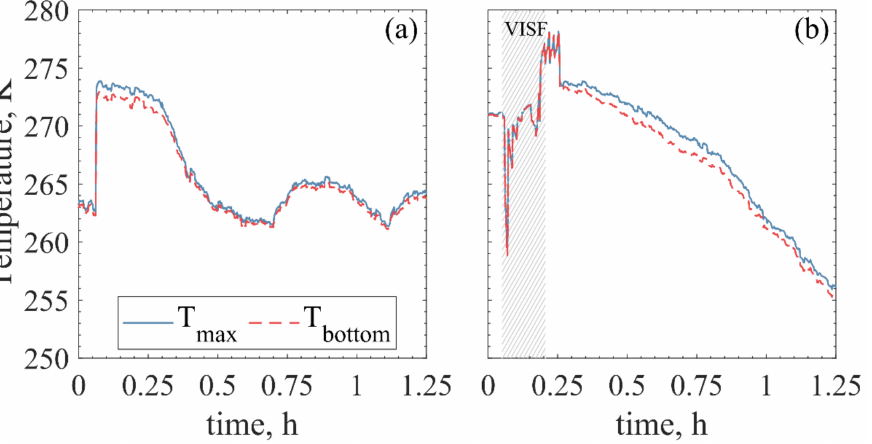
Figure 6. T max and T bottom during spontaneous nucleation ( a ) and VISF ( b ) at 271 K. (These are the same tests represented in Figure